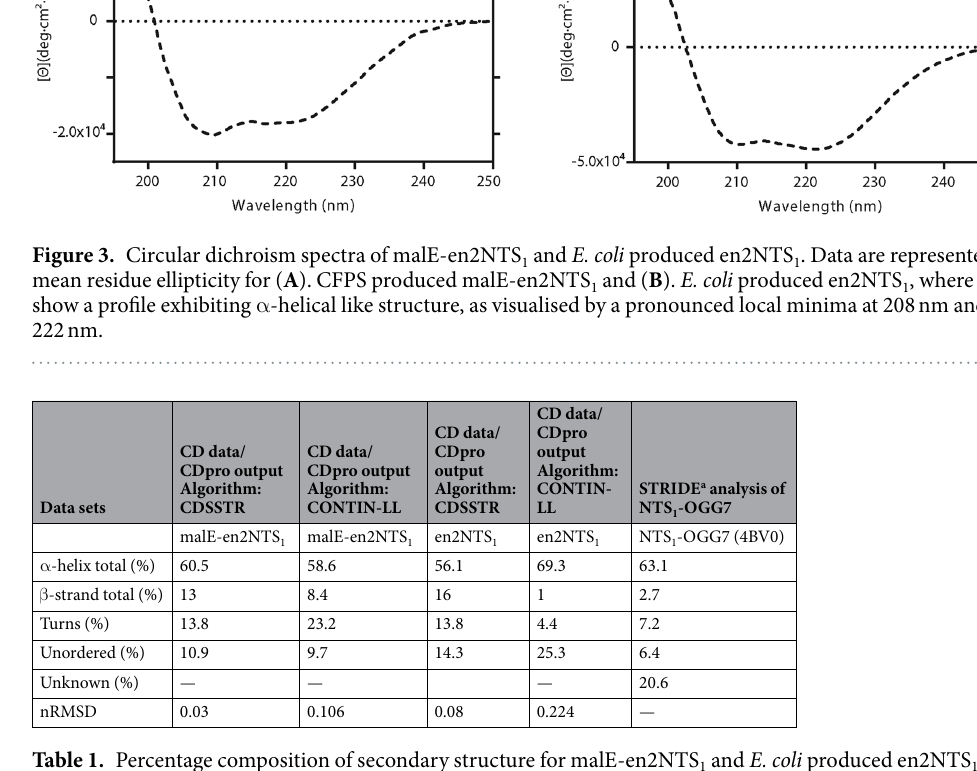
Table 1. Percentage composition of secondary structure for malE-en2NTS 1 and E. coli produced en2NTS 1 compared to structural data using pdb data inputted into STRIDE. a STRIDE calculations were based on